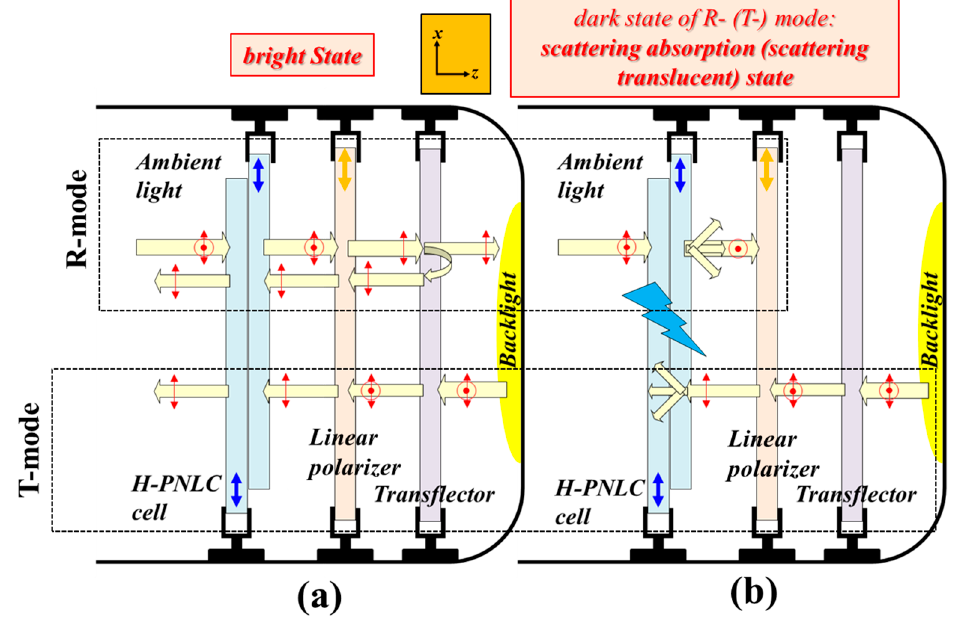
Figure 3. Configurations of a pixel of the ST-TRLCD#1 using an H-PNLC cell in ( a ) voltage-off bright (R- and T-modes) states and ( b ) voltage-on scattering-absorption (R-mode) and voltage-on scattering-translucent (T-mode) states. The “light blue thunder” symbol represents that the H-PNLC cell is being applied with a suitable electric field. Blue arrows plotted in H-PNLC cells and orange arrows plotted in linear polarizers represent the rubbing directions of the two substrates of an H-PNLC cell and the transmissive axes of linear polarizers, respectively; red arrows and dots represent the polarization states of LPL.